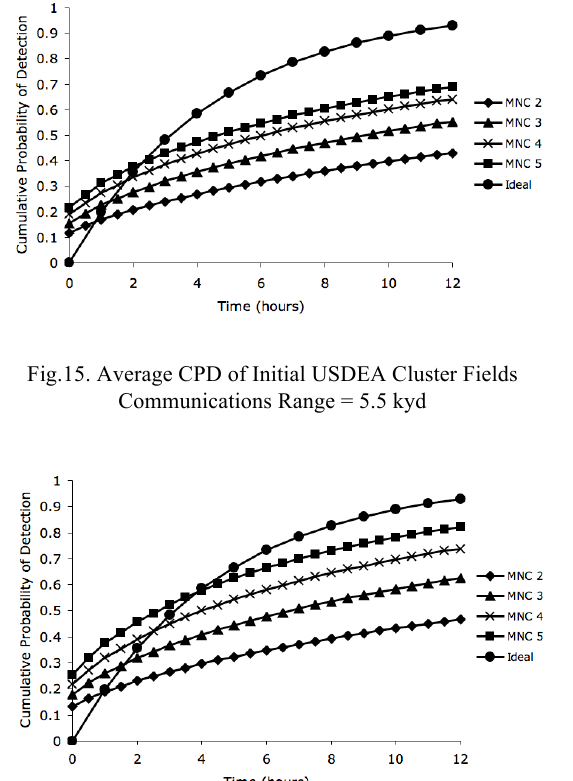
Fig.16. Average CPD of Final USDEA Cluster Fields Communications Range = 5.5